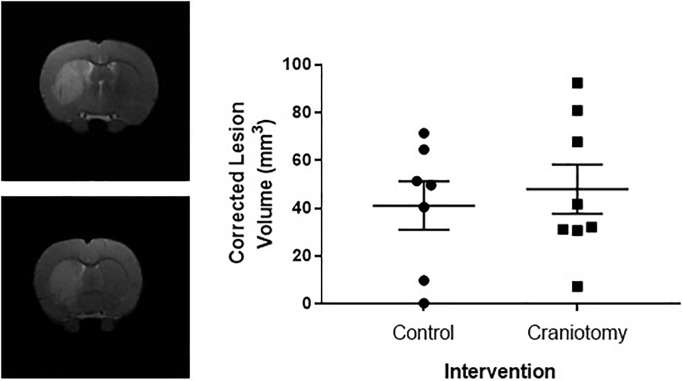
Effect of craniotomy on ischemic lesion volume as calculated from T2-weighted MRI images.(a) Representative T2-weighted MRI coronal images from the control group (a) and craniotomy (b) group of the lesion in the rat brain. (c) Graph showing lesion volume (mm3) and corrected against the size of the contralateral hemisphere to account for swelling. There was no significant difference in lesion volume between groups (control n = 7, craniotomy n = 8).